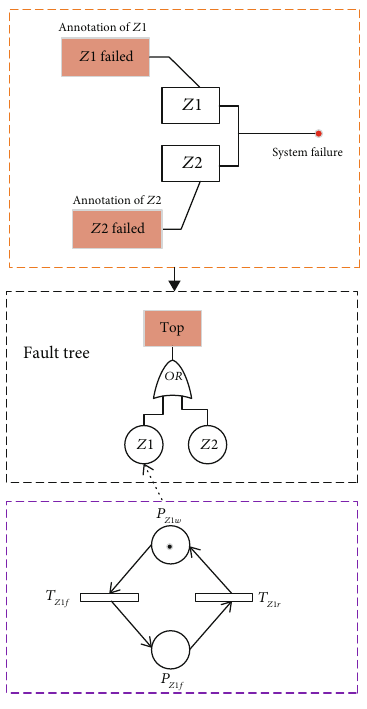
Figure 4: FTGPN is illustrated with a simple example.